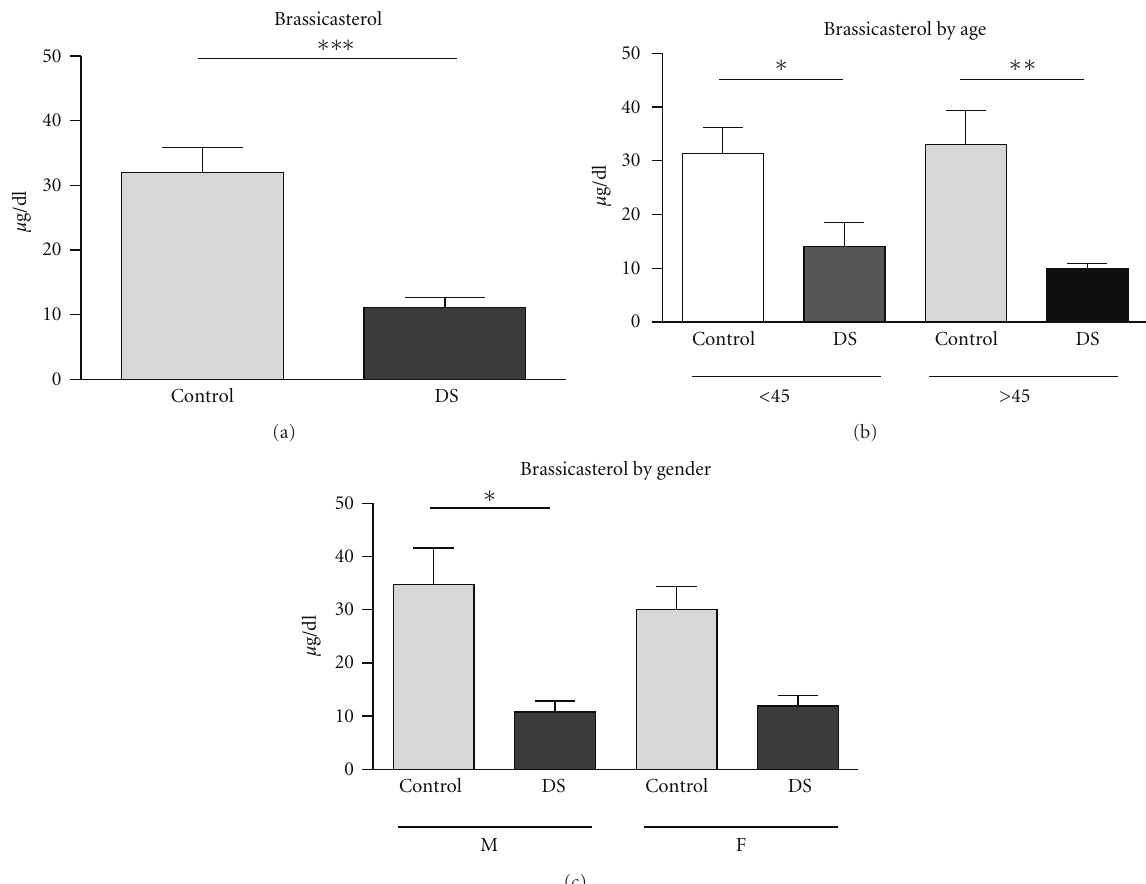
Figure 1: Serum brassicasterol levels are reduced in Down Syndrome (DS) subjects. Serum brassicasterol levels were quantified by GC-MS in N = 20 DS and N = 22 healthy controls (CON). (a) Mean and standard error of brassicasterol levels in the total CON and DS sample. (b) Mean and standard error of brassicasterol levels in the CON and DS subjects < 45 and > 45 years of age. (c) Mean and standard error of brassicasterol levels in male and female CON and DS subjects. Data were analysed by Students t -test. ∗ represents P < 0 . 05, ∗∗ represents P < 0 . 01, and ∗∗∗ represents P < 0 .